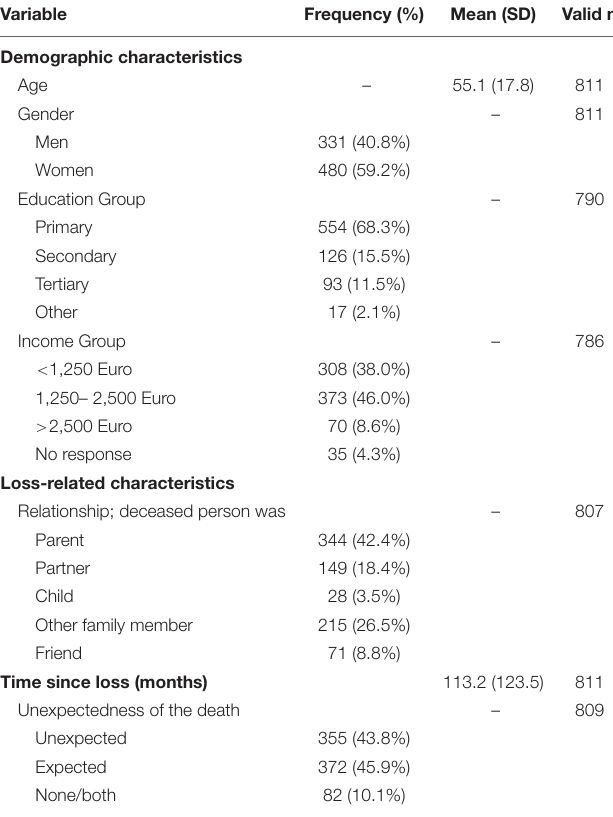
TABLE 1 | Demographic and loss-related characteristics.